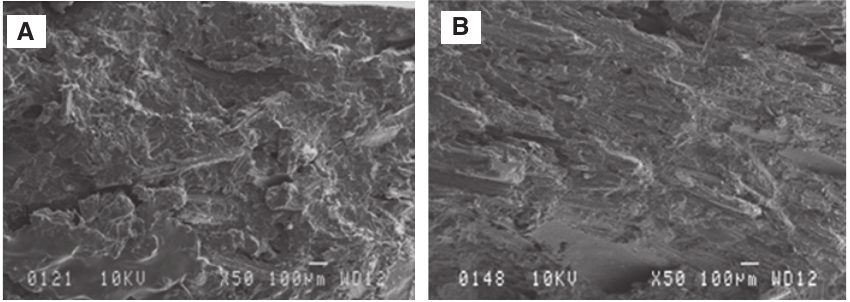
Figure 14 Fracture surface of PP triticale composites: (A) 20% and (B) 50% triticale with coupling